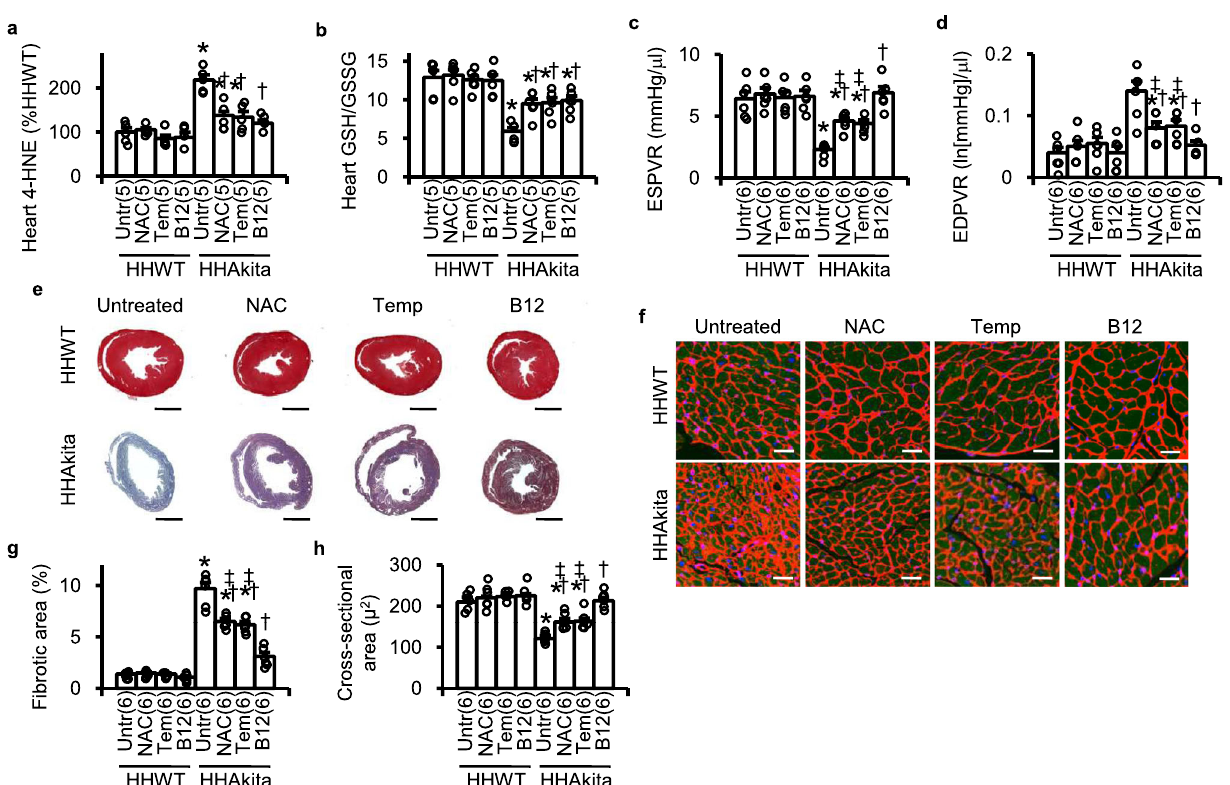
Fig. 3 Antioxidative and cardioprotective effects of B12 (10 mg/kg/day) compared to those of N-acetyl- L -cysteine (NAC; 1000 mg/kg/day), and tempol (Tem; 200 mg/kg/day). Mice having high expression levels of ELMO1 without and with Akita diabetetogenic mutation (HHWT and HHAkita, respectively) were administered with NAC, Tem and B12 in their drinking water starting at 8 weeks of age for 16 weeks. a Cardiac levels of 4-hydroxy-2- nonenal (4-HNE). b The ratio of reduced glutathione (GSH) to oxidized glutathione (GSSG) in the heart. c End-systolic pressure – volume repationship (ESPVR) . d End-diastolic pressure – volume repationship (ESPVR). e AZAN trichrome staining of the heart. Scale bar = 1 mm. f Representative photomicrographs of cross-sections of cardiomyocytes stained with wheat germ agglutinin (red), anti- α -actinin antibody (green) and 4 ’ ,6-diamidino-2- phenylindole (DAPI; blue). Scale bar = 10 µ m. g Proportion of fi brotic areas. h Cross-sectional areas of cardiomyocytes. Data are expressed as means ± standard errors. Numbers in the parentheses indicate the number of animals studied. * P < 0.05 vs. untreated (Untr) HHWT mice by Tukey – Kramer Honestly Signi fi cant Differences test after one-way ANOVA; † P < 0.05 vs. untreated HHAkita mice. ‡ P < 0.05 vs. B12-treated HHAkita